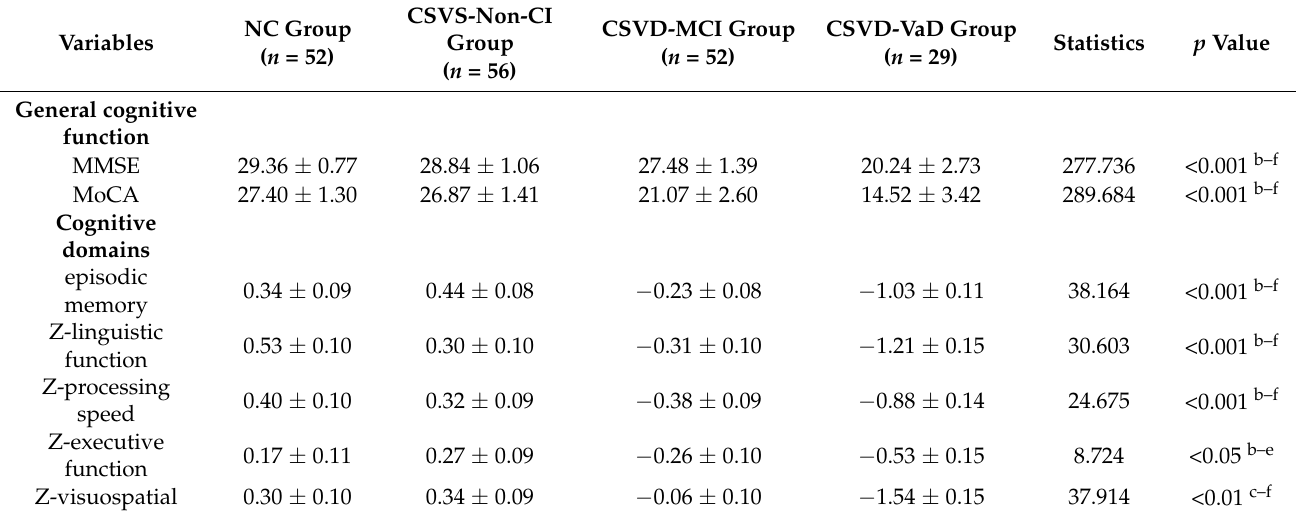
Table 2. Cognitive function in NC, CSVD-non-CI, CSVD-MCI, and CSVD-VaD groups.